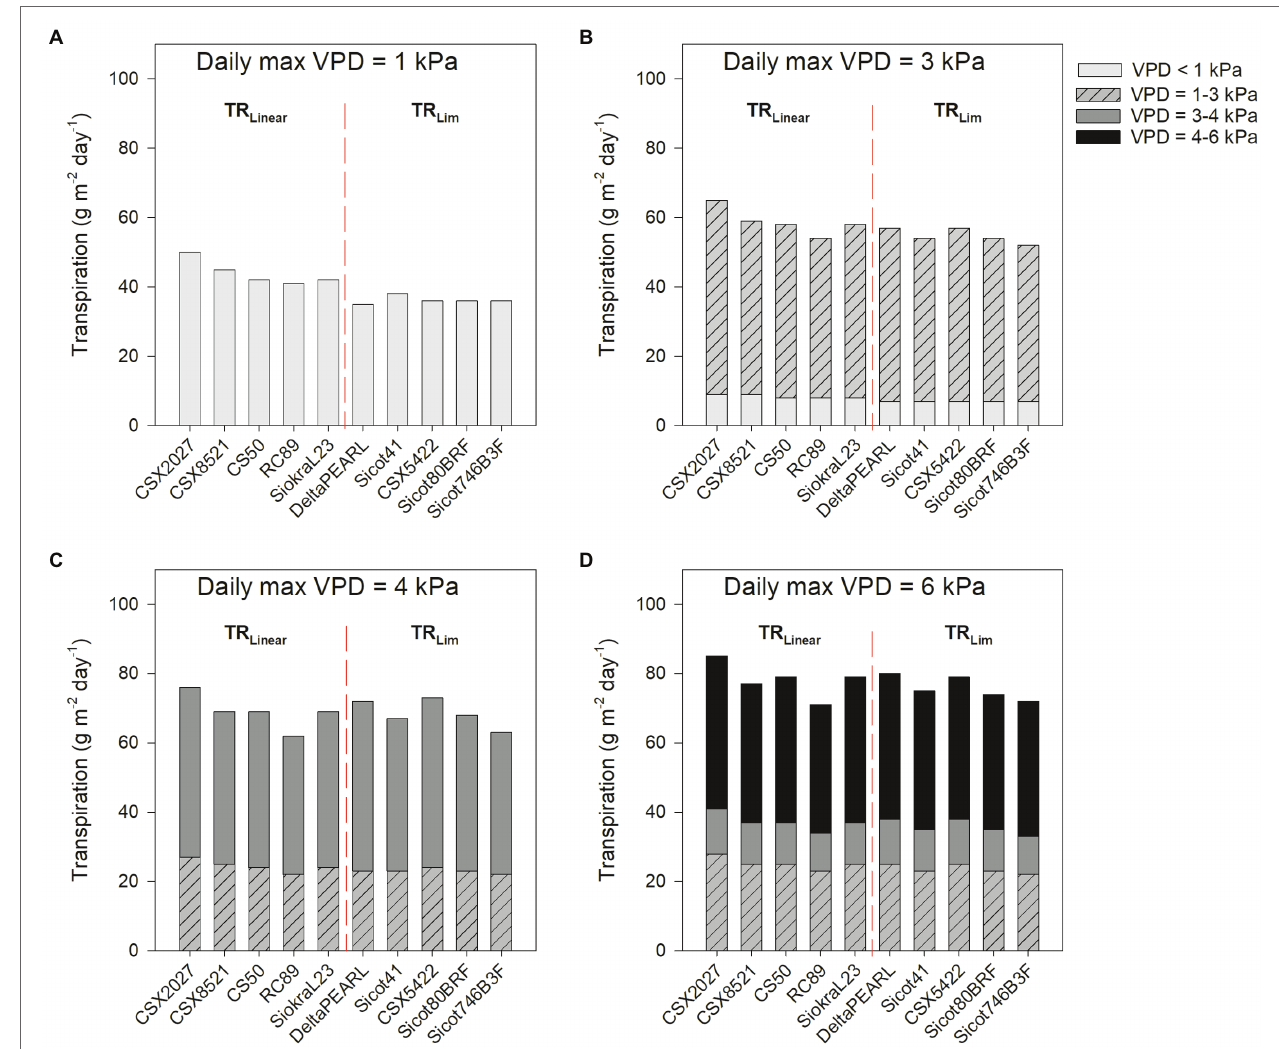
FIGURE 3 | Daily transpiration (g m − 2 day − 1 , from sunrise until sunset) of 10 cotton genotypes for 4 days representing differing VPD conditions in Narrabri, Australia, during peak flowering. (A) Max VPD = 1.0 kPa (6 February 2021), (B) Max VPD = 3.2 kPa (21 January 2021), (C) Max VPD = 4.4 kPa (27 January 2021), and (D) Max VPD = 6.0 kPa (17 January 2019). VPD environments range from VPD < 1 kPa (light grey), 1–3 kPa (hashed grey), 3–4 kPa (dark grey), and 4–6 kPa (black). The red dashed line separates TR Linear and TR Lim genotypes.